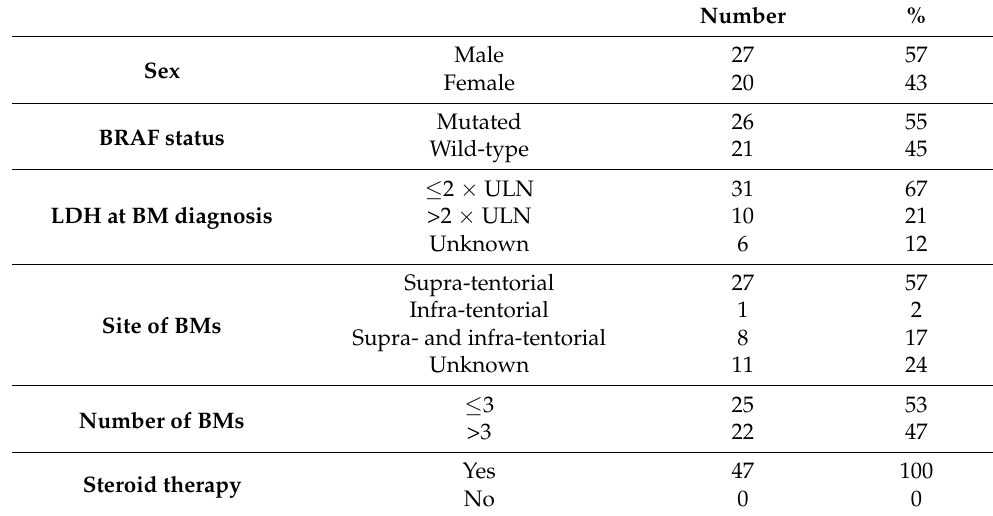
Table 3. Features of symptomatic